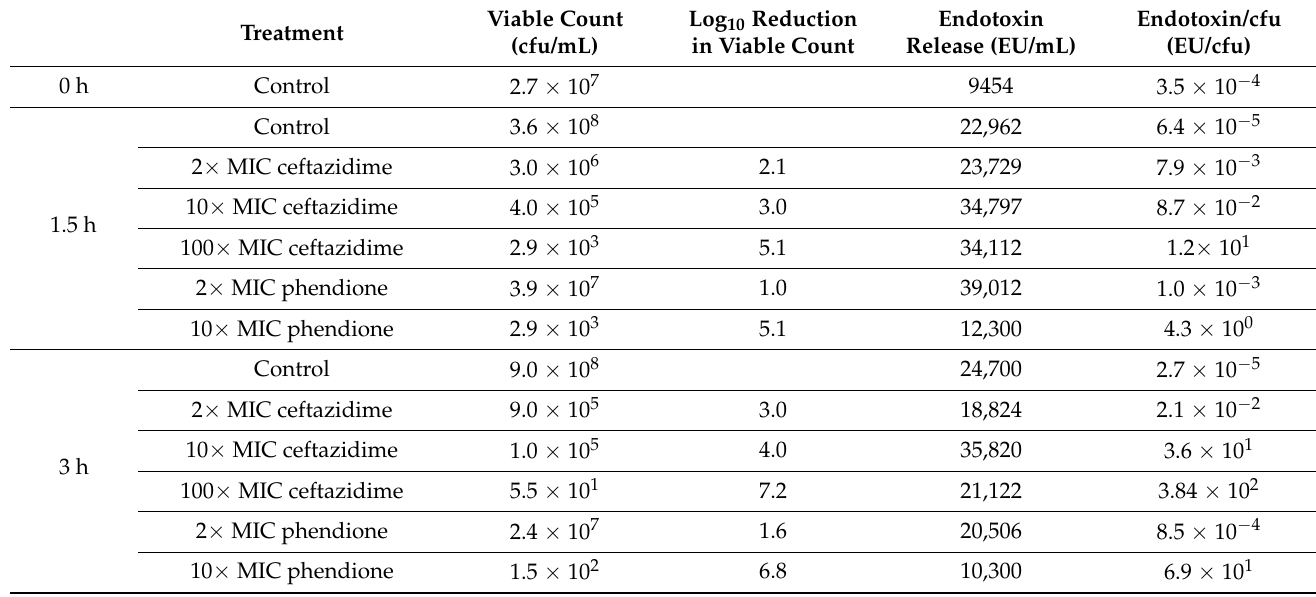
Table 3. Viable counts and endotoxin release for ESBL-producing E. coli isolate over a 3 h exposure period to ceftazidime and phendione at the concentrations of 2 × MIC, 10 × MIC and 100 ×